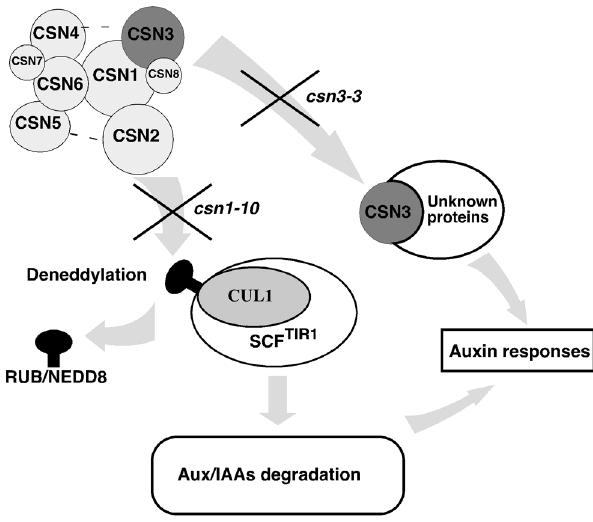
Figure 7. The CSN3 subunit plays multiple roles in auxin signaling. We hypothesize that in addition to its role in the CSN as a cullin deneddylase, the CSN3 subunit also regulates auxin signaling independently of the SCF TIR1/AFB ubiquitin-ligase. This second regula- tory mechanism may involve the small CSN3-containing complex whose assembly is disrupted by the csn3-3 point